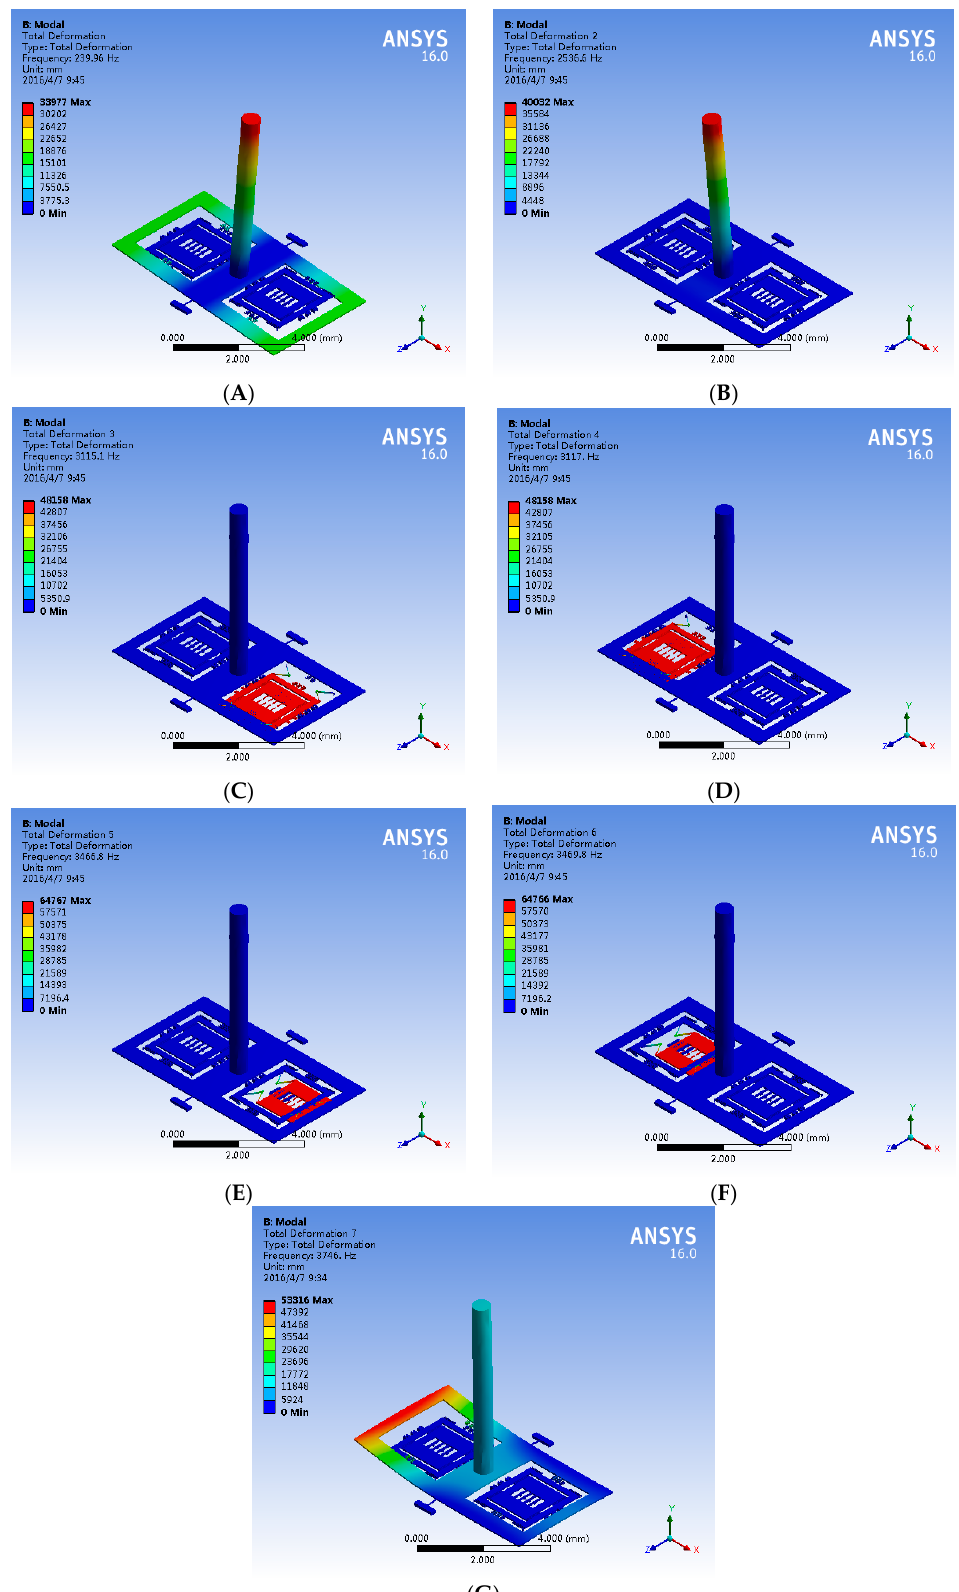
Figure 2. The structure mode of hair sensor. ( A ) The air flow and acceleration sense mode; ( B ) The bending mode of the hair post; ( C ) The resonator mode 1; ( D ) The resonator mode 2; ( E ) The gyroscope sense mode 1; ( F ) The gyroscope sense mode 2; ( G ) The curling mode of torsional frame.